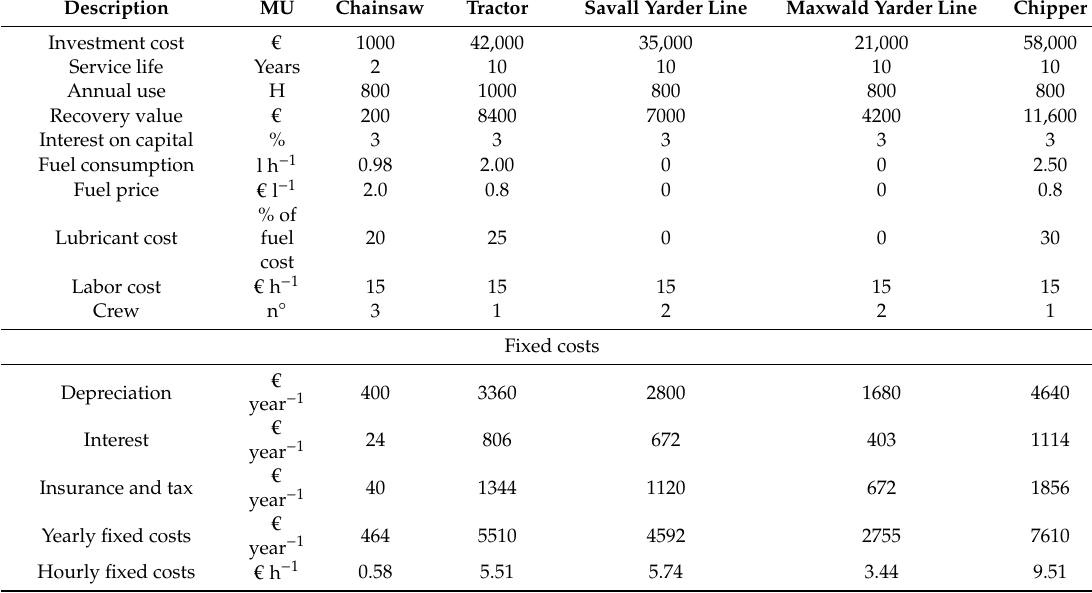
Figure 2. Average bunching—extraction productivity (bars) and possible increase of performance (lines) from SMH to PMH. Table 9. Machine costs (analytical), fixed, variable, and total operating costs (the Italian cost is referred to in the year 2019).